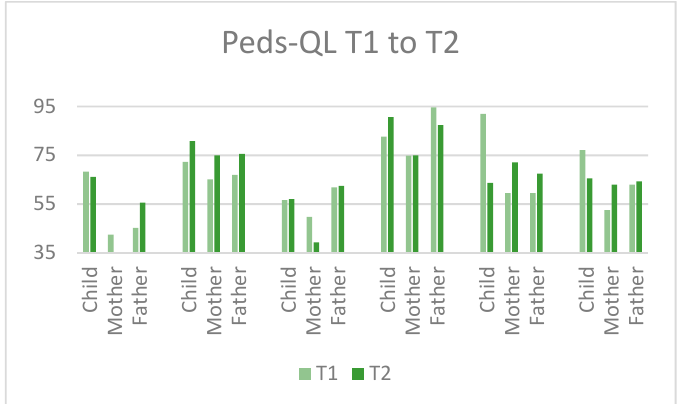
Figure 7. Ratings on the PEDS-QL for each family at T1 and T2. Higher scores imply higher reported quality of life.